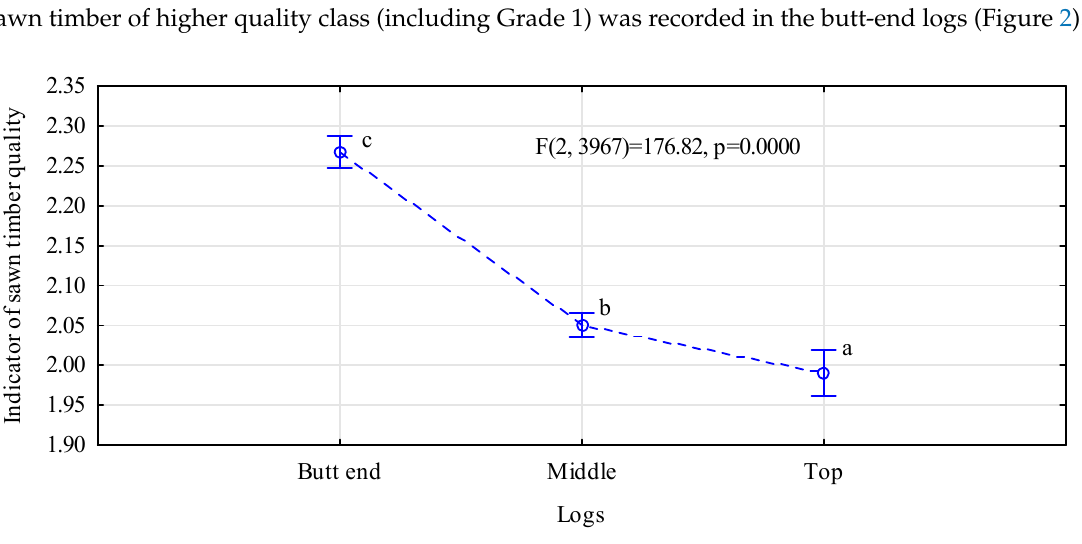
Figure 3. Interactions between the effect of the origin of long logs from a specific geographical region (forest division) and the exact section of long logs on the quality of main timber. Similar results as those for the Polish Standard were obtained using the European Standard PN- EN 1611-1. Grade 3 was the most numerous quality class of the sawn timber. Differences between the two grading procedures related to Grade 4, i.e., the lowest quality class. In the method based on the European standard, the amount of Grade 4 sawn timber was definitely larger. Compared with the method described in the Polish Standard, lower percentages of sawn timber represented, most of all, Grades 1 and 2 (Table 3).